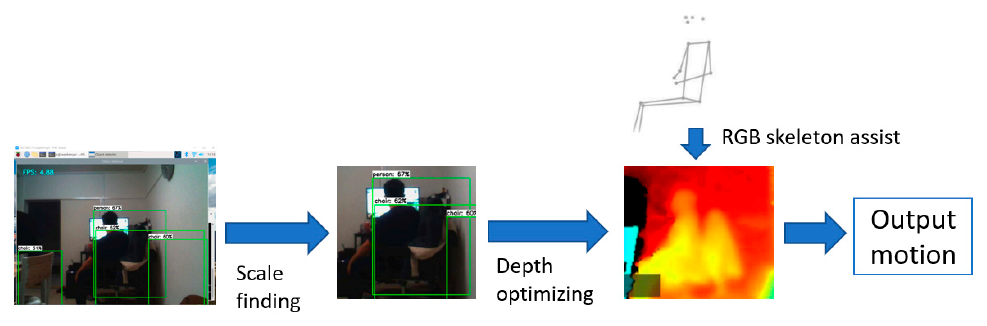
Figure 2. SDI method process .